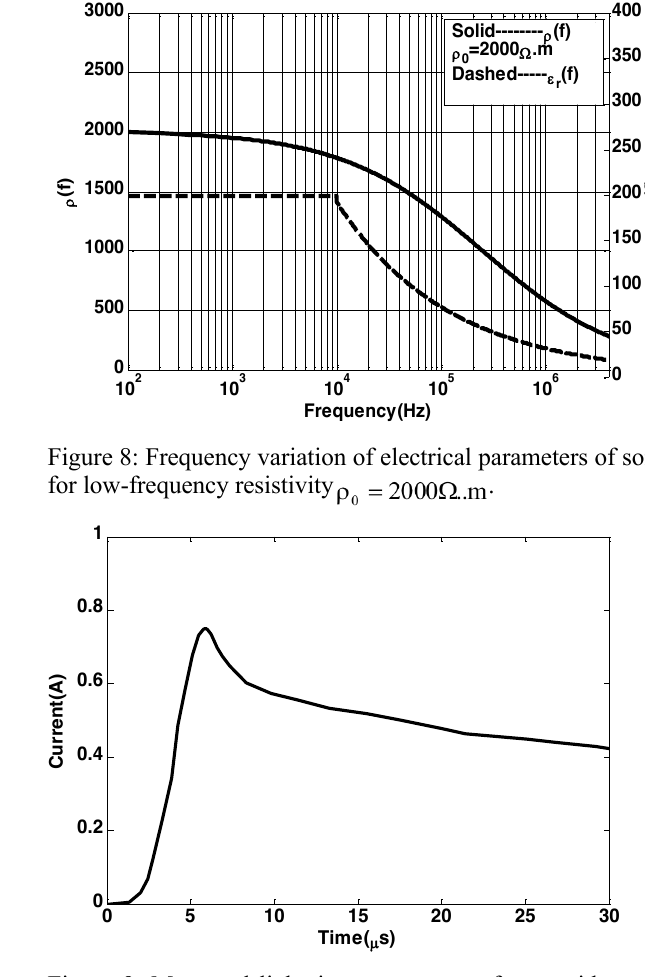
Figure 9: Measured lightning current waveforms with front-time used in the second example. Adapted from